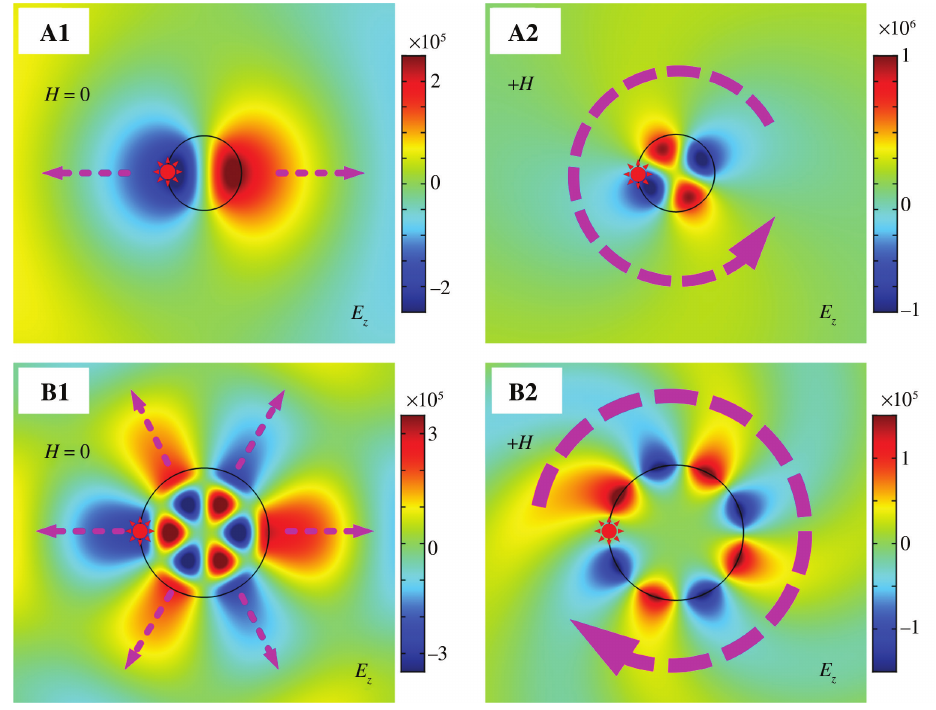
Figure 5: Numerical simulation results. (A1, A2) Single magneto-optical rod in air at f represent the transport direction of electromagnetic